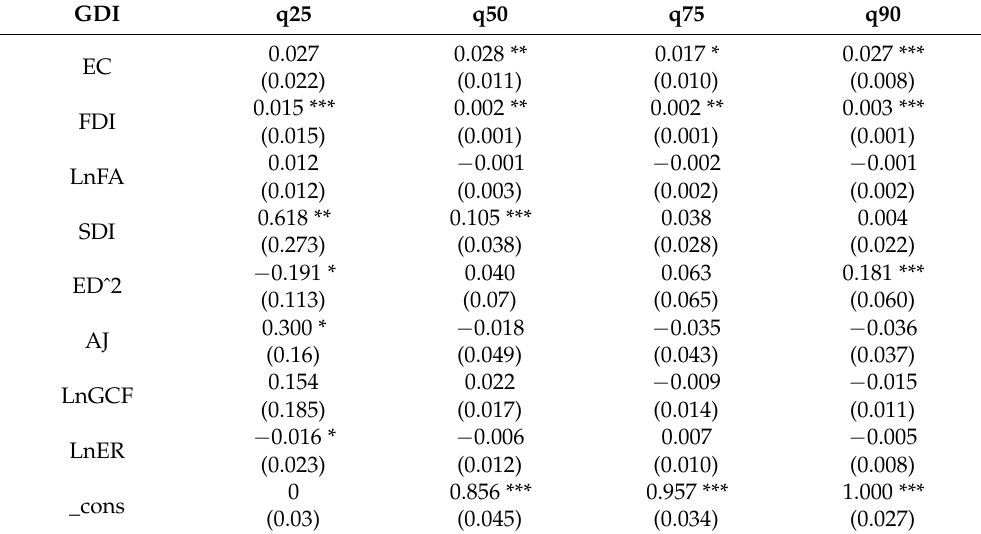
Table 5. Results of Generalised Quantile Regression 2000–2020 (In presence of the enhanced demo- cratic